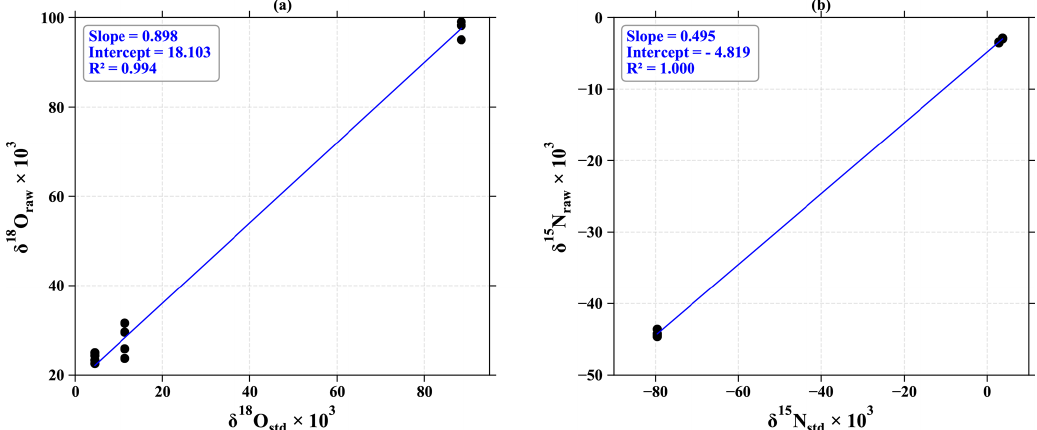
Figure A1. Calibration of (a) 18 O and (b) 15 N with nitrite standards at 100nmol measured by the chemical azide method. The measured δ 18 O ( δ 18 O raw ) and δ 15 N ( δ 15 N raw ) values of NO − standards are plotted against their certified reference δ 18 O ( δ 18 O std ) and δ 15 N ( δ 15 N std ) 2 values.